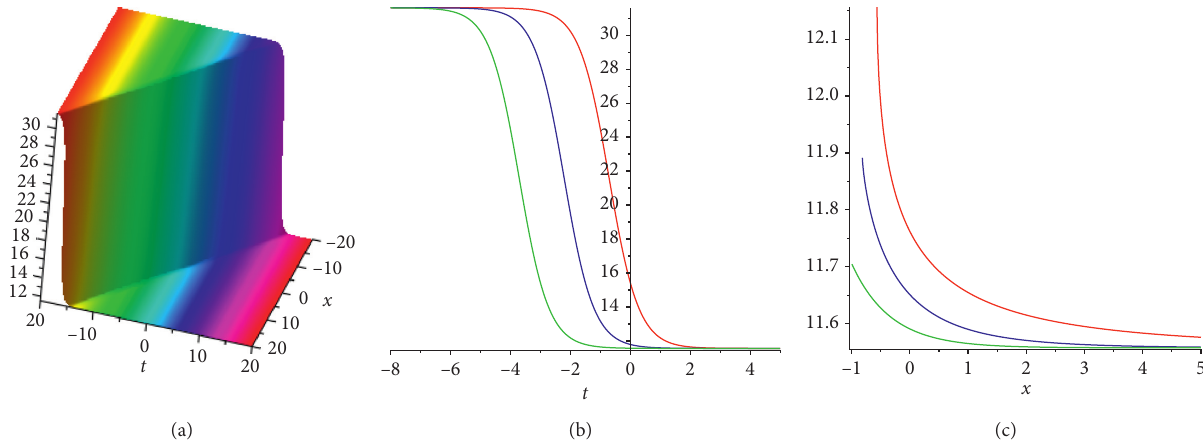
( x, t ) at A � 1 ,B � 2 ,a � 3 ,b � 2 ,k � 1 . 5 , ω � 2 , β � 3 , c � − 1 , and α � 1 for (a) 3D plot and (b) and (c) 2D 1 0 0